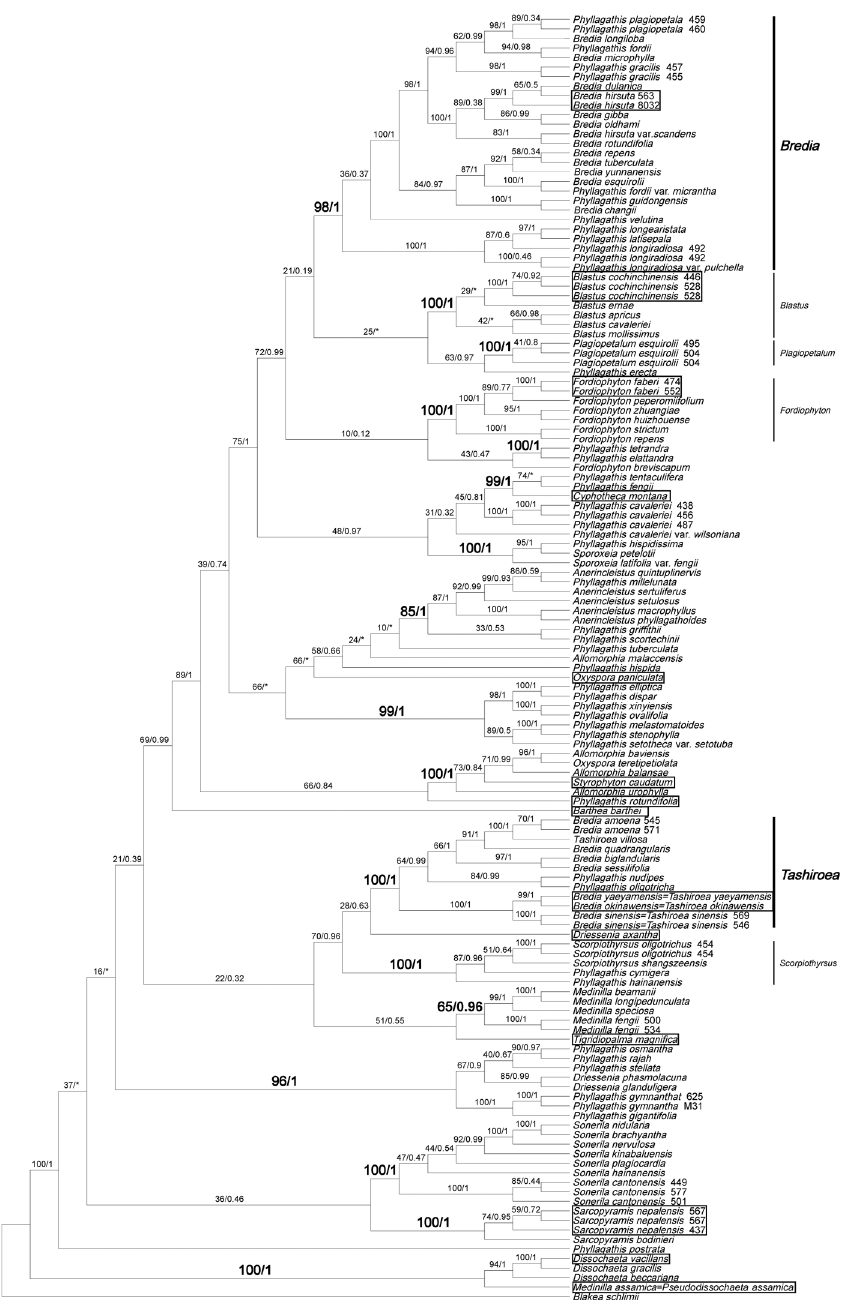
Figure 1. Maximum likelihood phylogenetic tree of Sonerileae/Dissochateae based on combined data- set of nuclear ribosomal internal transcribed spacer and chloroplast trnV-trnM sequences, showing the phylogenetic position of Tashiroea clade and Bredia clade. Numbers on the branches are bootstrap values obtained from maximum likelihood analyses (left) and Bayesian posterior probabilities (right) resulting from Bayesian inference. Boxes denote the types of the genera